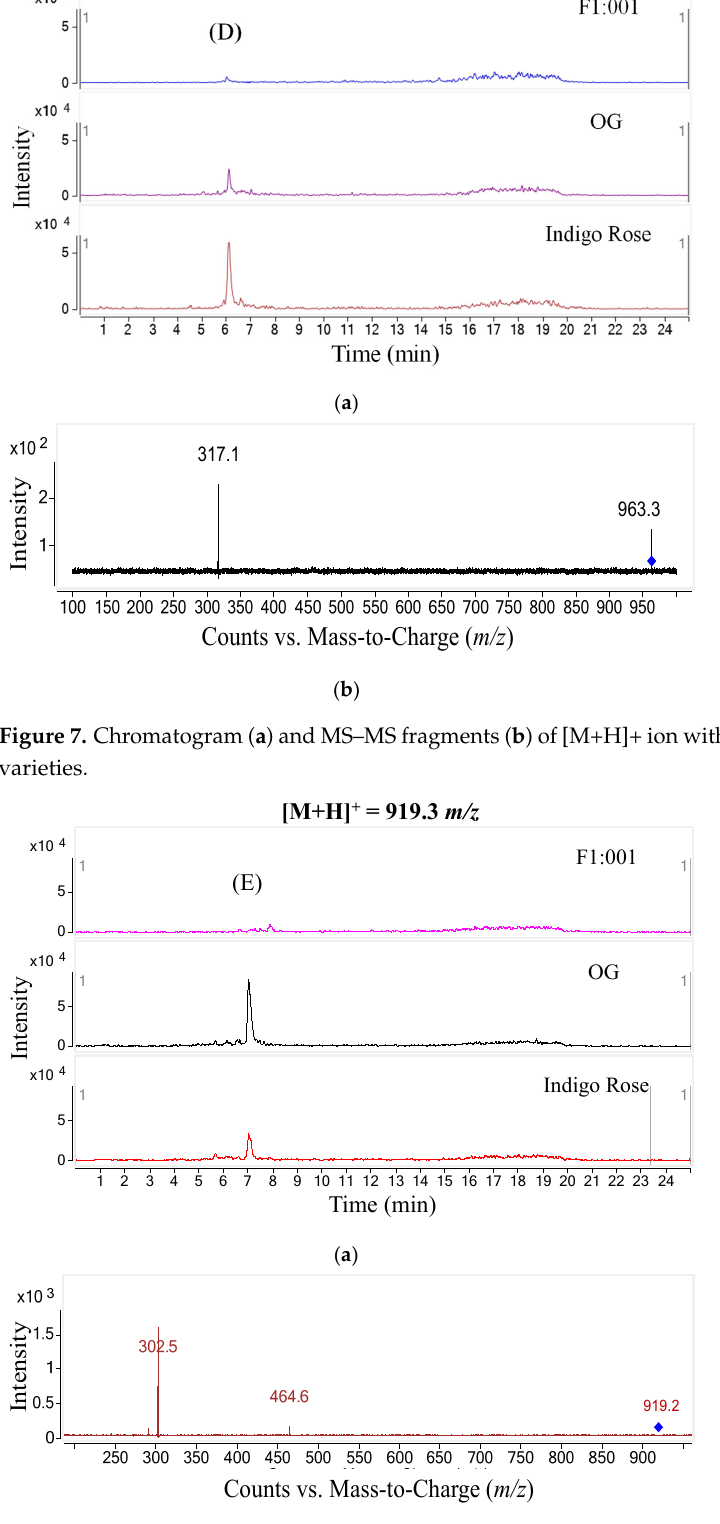
Figure 8. Chromatogram ( a ) and MS–MS fragments ( b ) of [M+H]+ ion with 919.3 m / z in three tomato varieties.